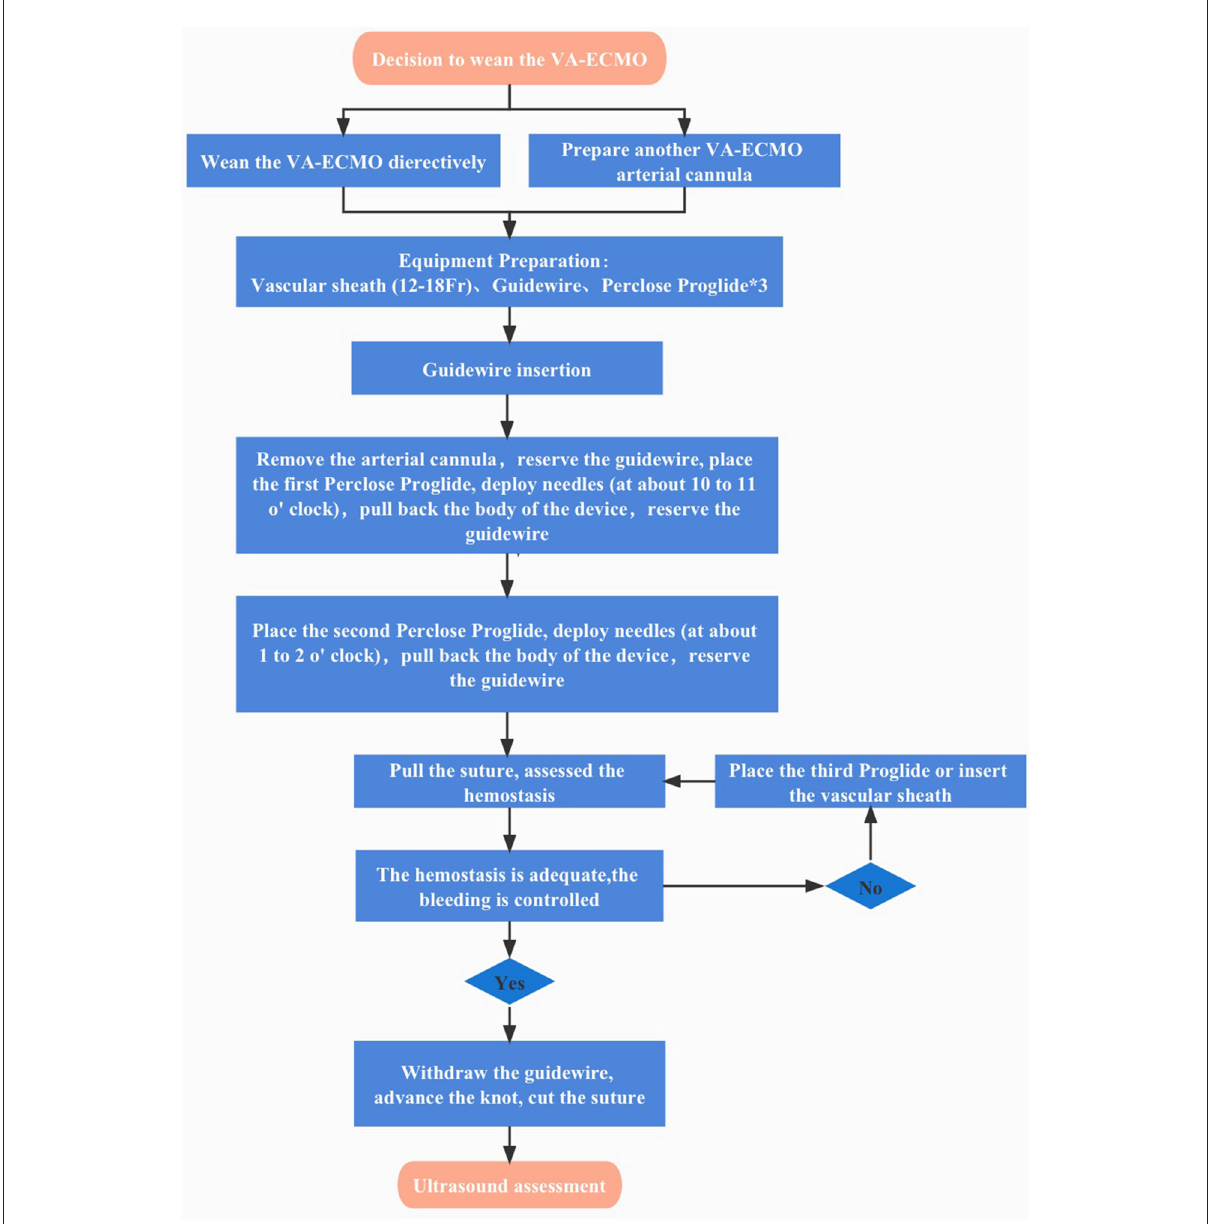
FIGURE2 Algorithm of total percutaneous post-closure of femoral arterial access sites after Veno-arterial Extracorporeal Membrane